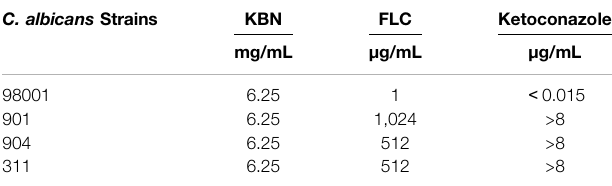
TABLE 3 | MIC of KBN against C. albicans .